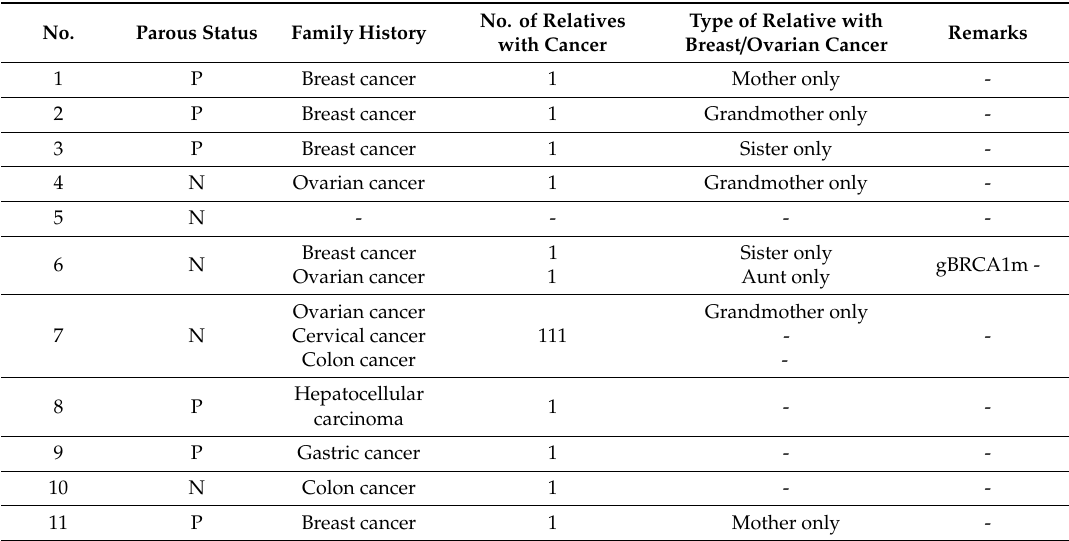
Figure 5. Imaging of the breasts on magnetic resonance imaging (MRI). ( a ) Breast MRI of patient No. 6 at the first diagnosis of breast cancer in October 2013. ( b ) Breast MRI of patient No. 6’s sister at the first diagnosis of breast cancer in January 2016. Table 4. Family history of patients with pathogenic mutations in both gBRCA1 and gBRCA2 and patients who had a gBRCA1 mutation and gBRCA2